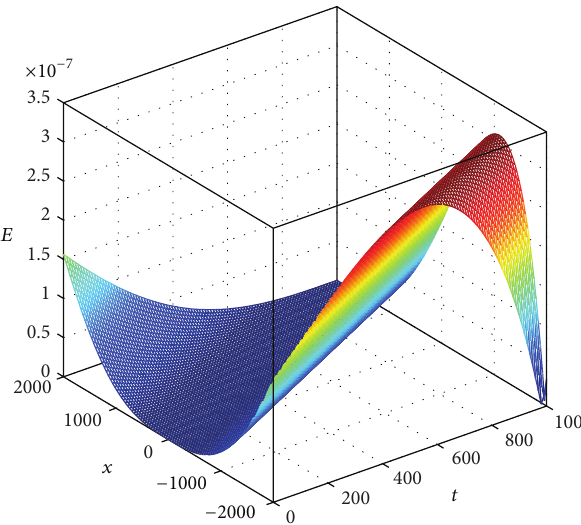
Figure1:AbsoluteerrorofBurgers-Huxleyequation,(1),with 𝛿 = 1 , 𝛾 = 0.001 , ] = 1 , and 𝜂 = 1 .